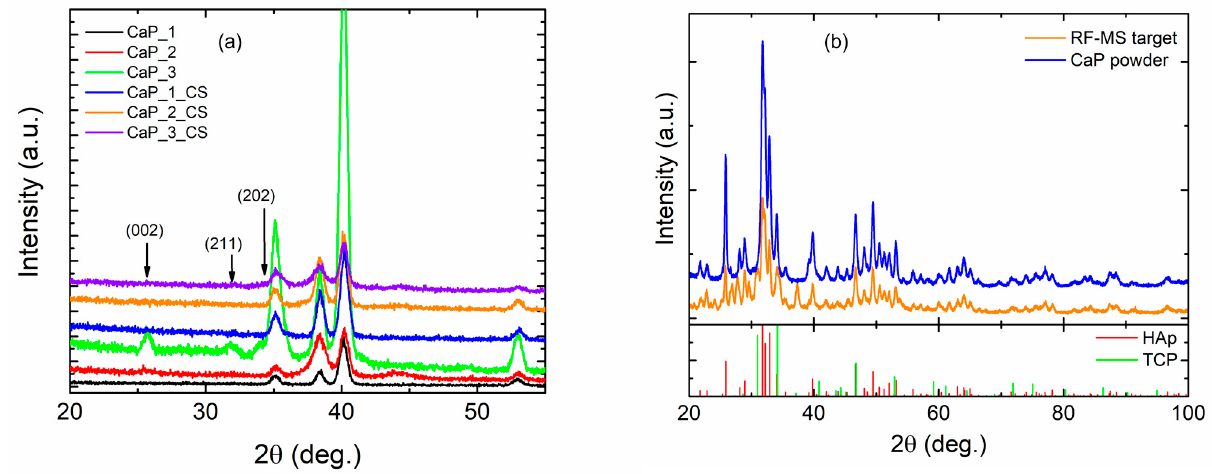
Figure 13. XRD results of ( a ) all samples deposited at different substrate temperatures and ( b ) initial CaP powder and sputtering target after preparation of samples.